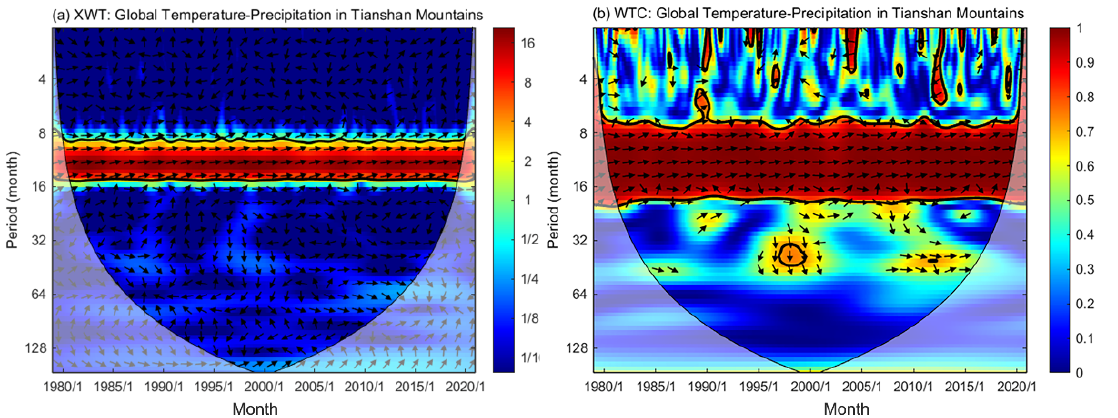
Figure 7. Cross-wavelet ( a ) and wavelet correlation ( b ) between global surface temperature and precipitation in Tianshan.